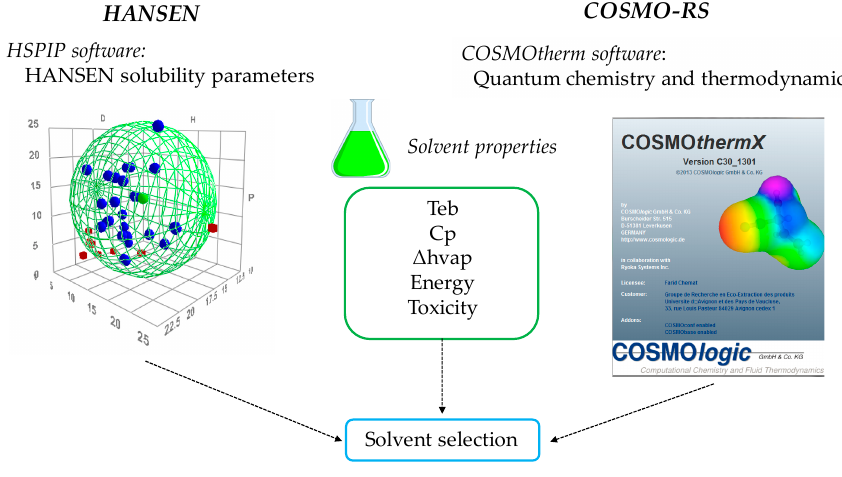
Figure 3. How to select a good and green solvent?